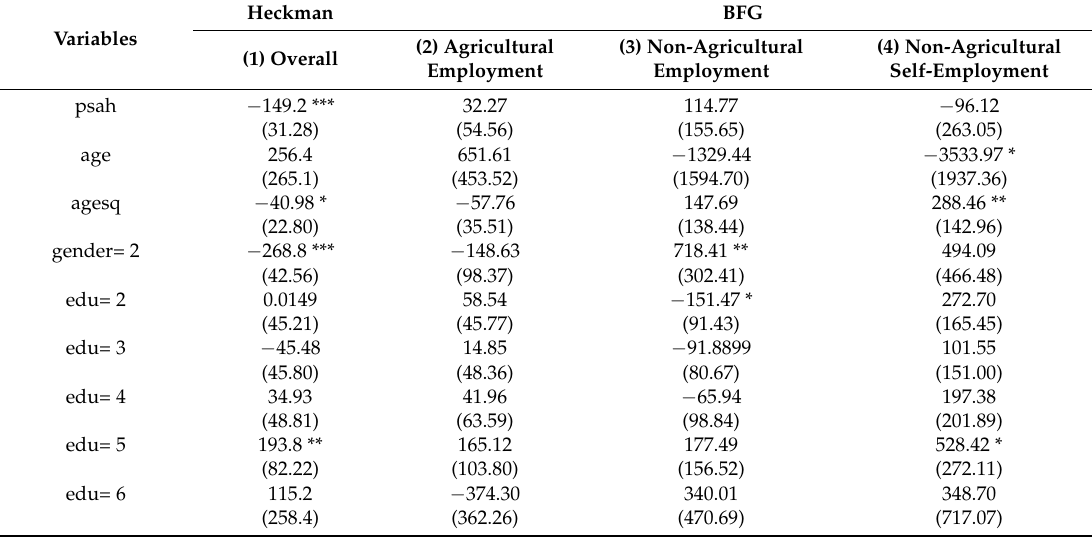
Table 3. Labour time decision of rural elderly